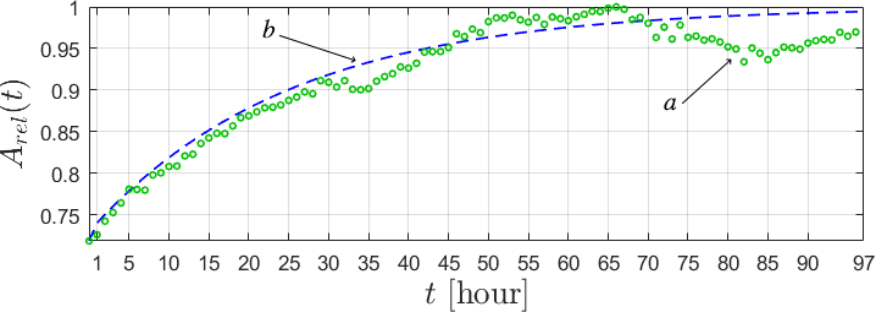
Figure 7. Data in relative units: (a) RVA values in the PRTR chamber; (b) simple model model curve (1) according to